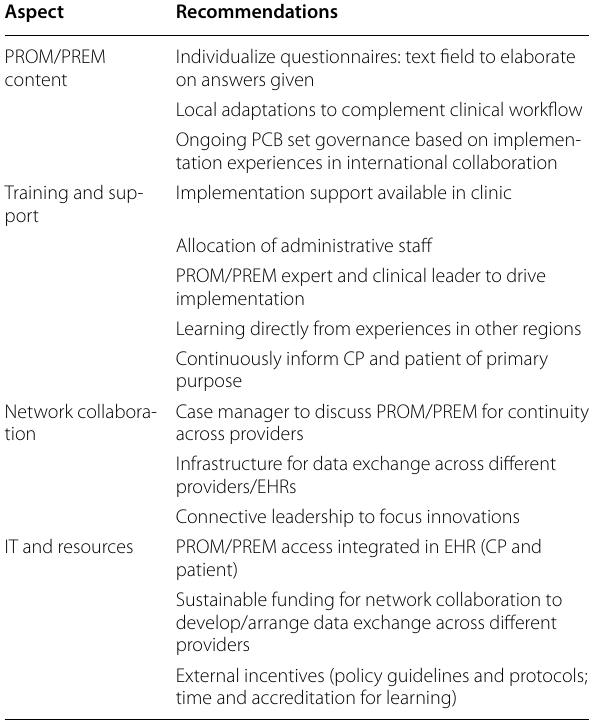
CP care professional, PCB set pregnancy and childbirth outcome set, PROM patient-reported outcome measures, PREM patient-reported experience measures, EHR electronic health record